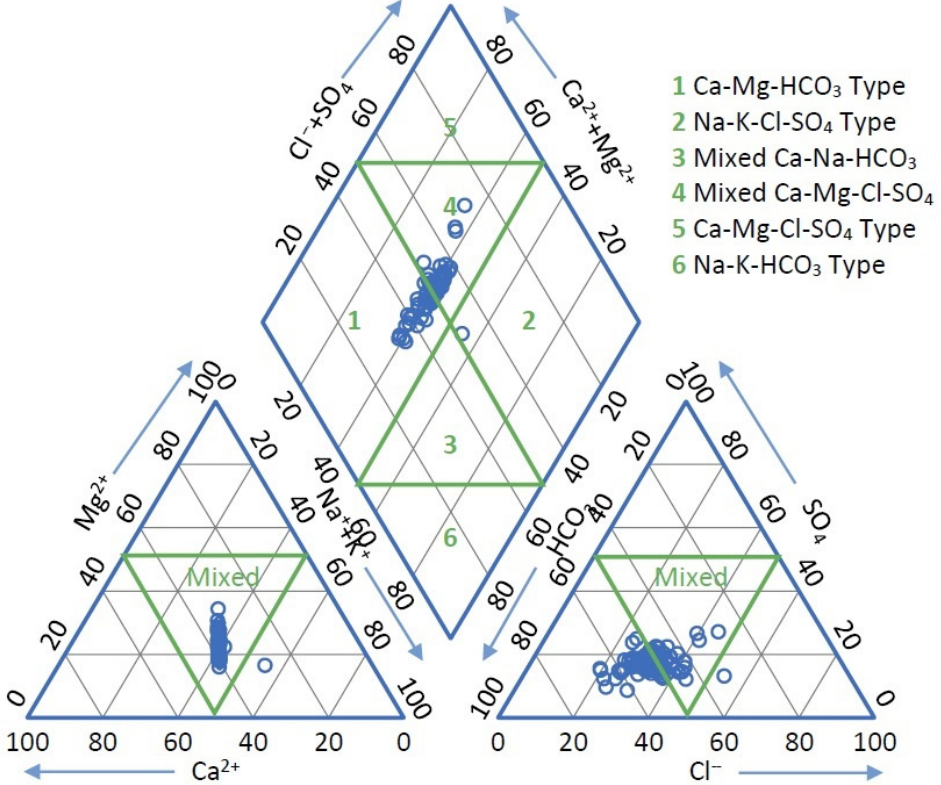
Figure 2. Piper diagram for groundwater samples collected from Târgovi ş te Plain.